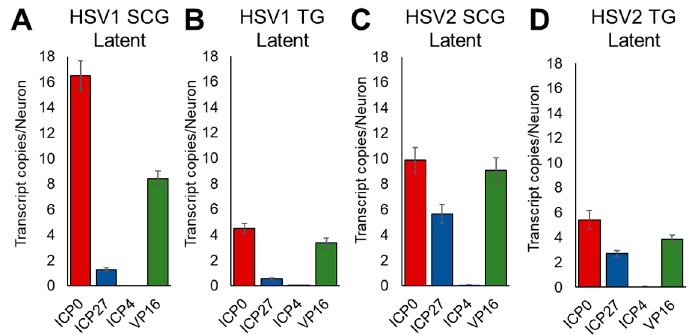
Figure 4. HSV-1 and HSV-2 ICP0, ICP27, ICP4, and VP16 gene expression in SCG and TG neurons during latency. Gene expression was quantified by droplet digital PCR (ddPCR) 7 days after infec- tion in the presence of acyclovir (300 µM). Data is shown as gene transcripts per neuron. ( A ) HSV- 1 in SCG neuronal cultures. ( B ) HSV-1 in TG neuronal cultures. ( C ) HSV-2 in SCG neuronal cultures.